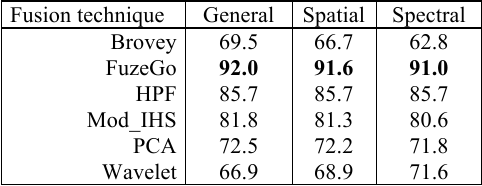
Table 5. Overall results of the visual quality assessment in % (Fries 2017). Ehlers, Manfred. 2004. Spectral characteristics preserving image fusion based on Fourier domain filtering.